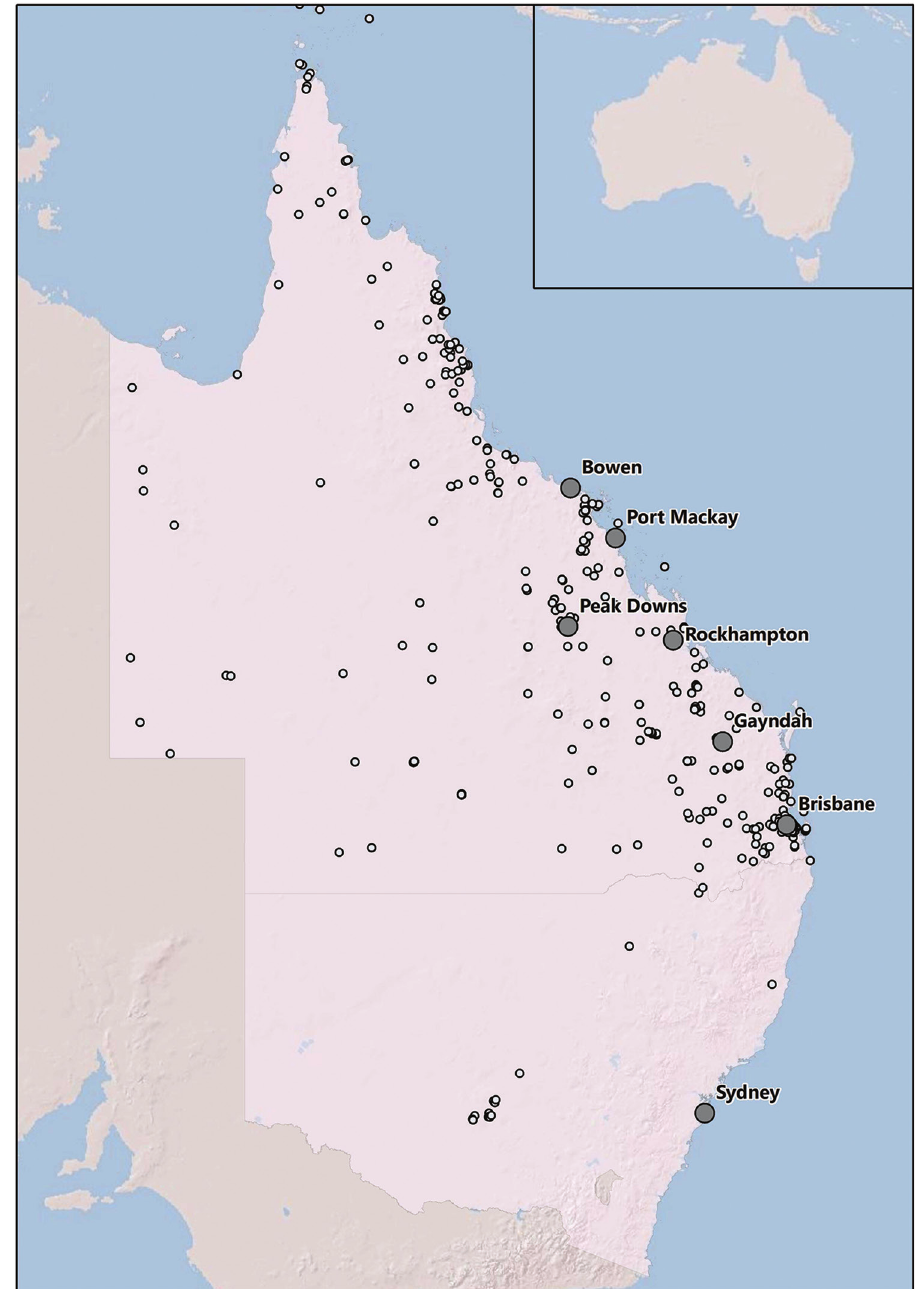
Figure 22. Distribution map of the genus Oxyopes in Queensland. Large grey dots are the localities of the here re-described Oxyopes species (photo: Michael